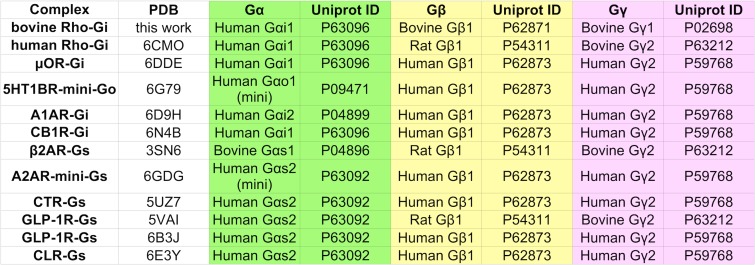
Details of the source organism of the Gα, Gβ, and Gγ proteins used to obtain GPCR G-protein complexes for structure determination.